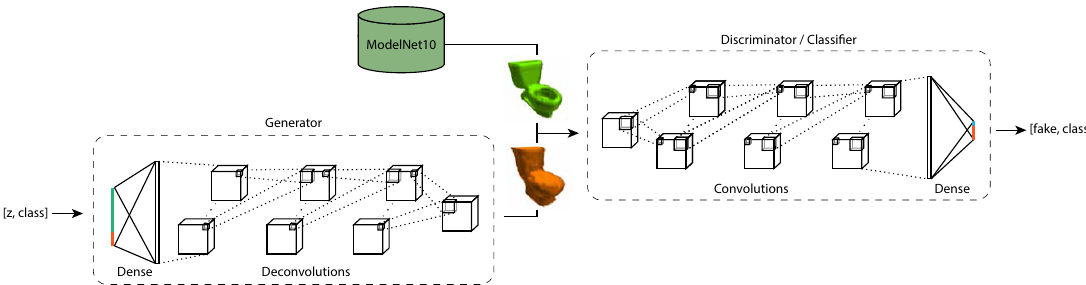
Figure 4. Architecture of the whole 3D conditional generative adversarial network classifier. Generator and discriminator are connected sequentially. The discriminator is fed both real (green) and fake (orange) examples during